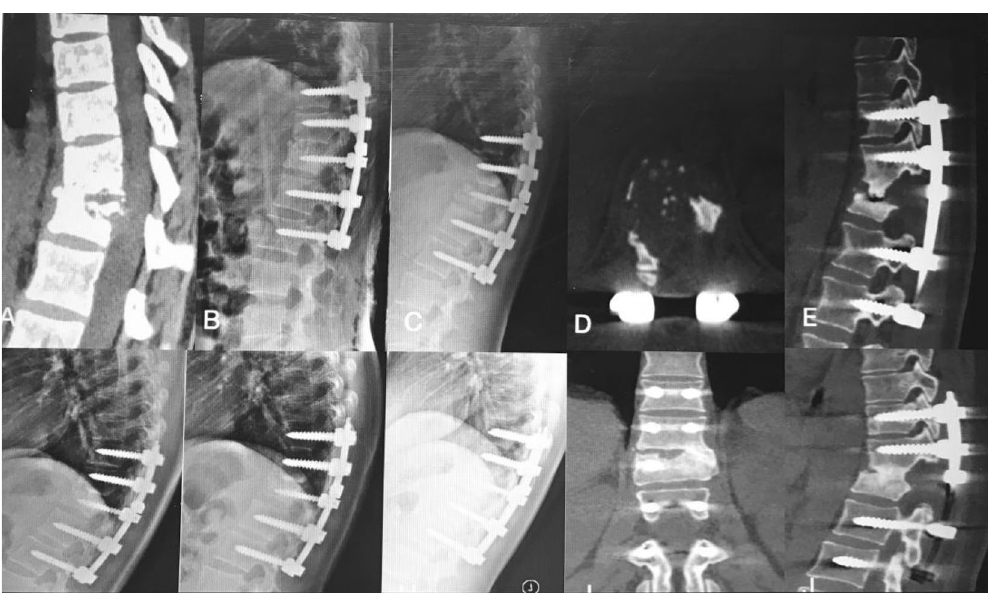
Figure 3. A 22-year-old female patient with thoracic spinal tuberculosis (T11–12) underwent posterior debridement and decompression combined with instrumentation. ( A ) Preoperative computed tomography (CT) shows bone destruction of the T11–12 vertebrae and compression of the spinal cord. ( B – E ) The 1-week and 6-month postoperative X-rays and 6-month postoperative CT show the correction was maintained, but the bone was not fully healed. ( F , G ) The 1-year and 2-year postoperative X-ray show the kyphosis correction had been lost. ( H – J ) At 5-year FU, plain X-ray and CT showed solid bone